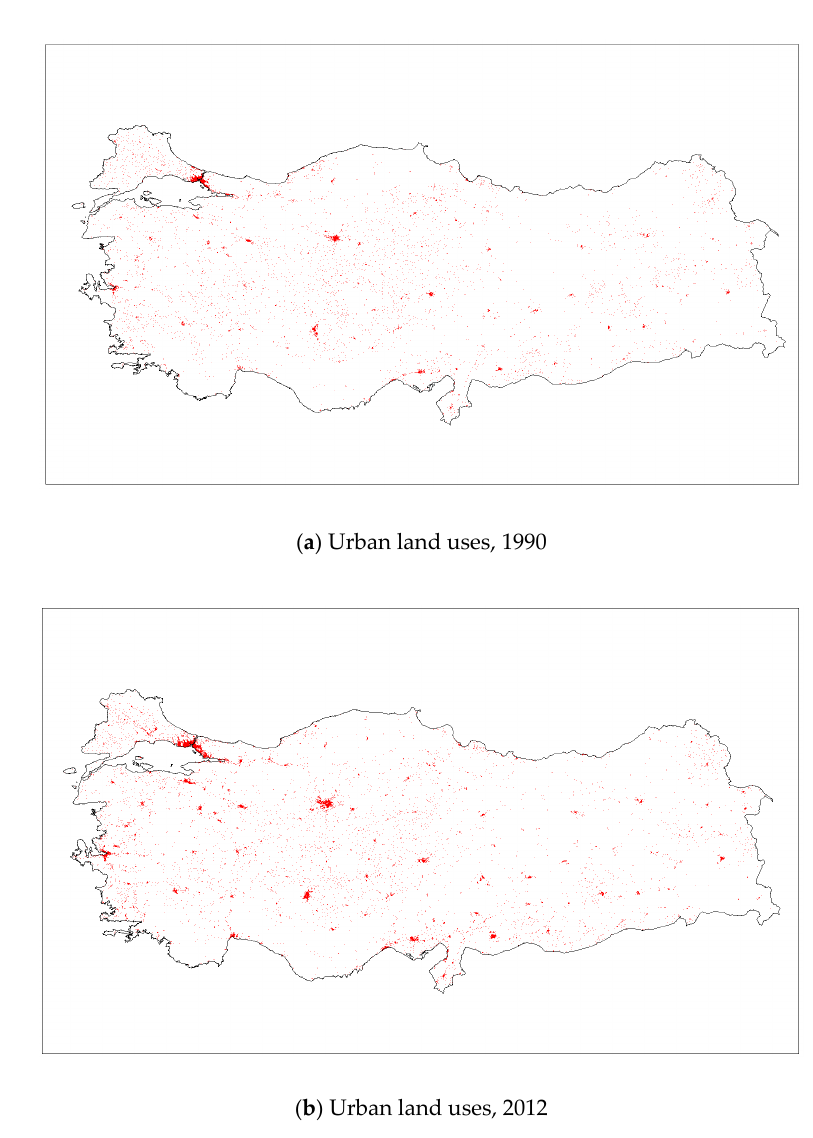
Figure 6. Spatial distribution of urban land uses in Turkey (1990; 2012). Table 1. Land-use changes during the study period.